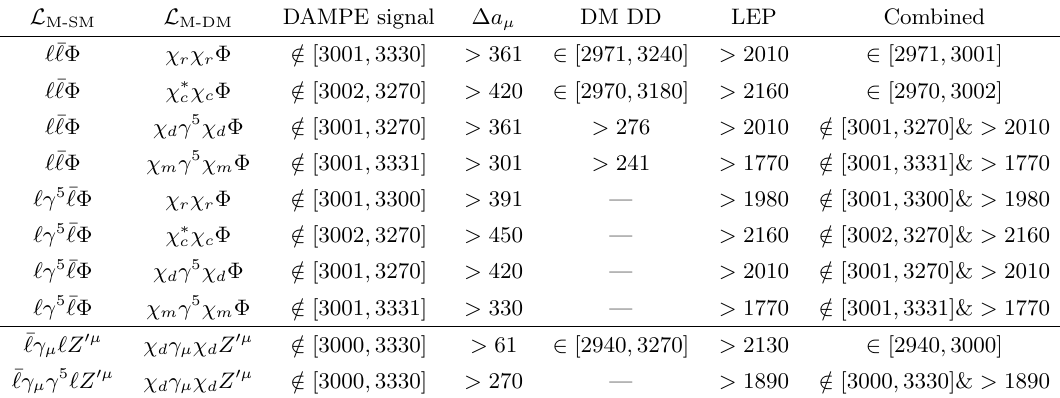
Table 2 . Regions in mediator mass permitted by experimental constraints for combinations of mediator couplings to the SM leptons and DM. The constraint DM DD stands the spin-independent DM direct detection constraints currently provided by PandaX. The (cid:12)nal column shows mediator masses that may explain DAMPE and simultaneously satisfy all experimental constraints. All masses are in units of